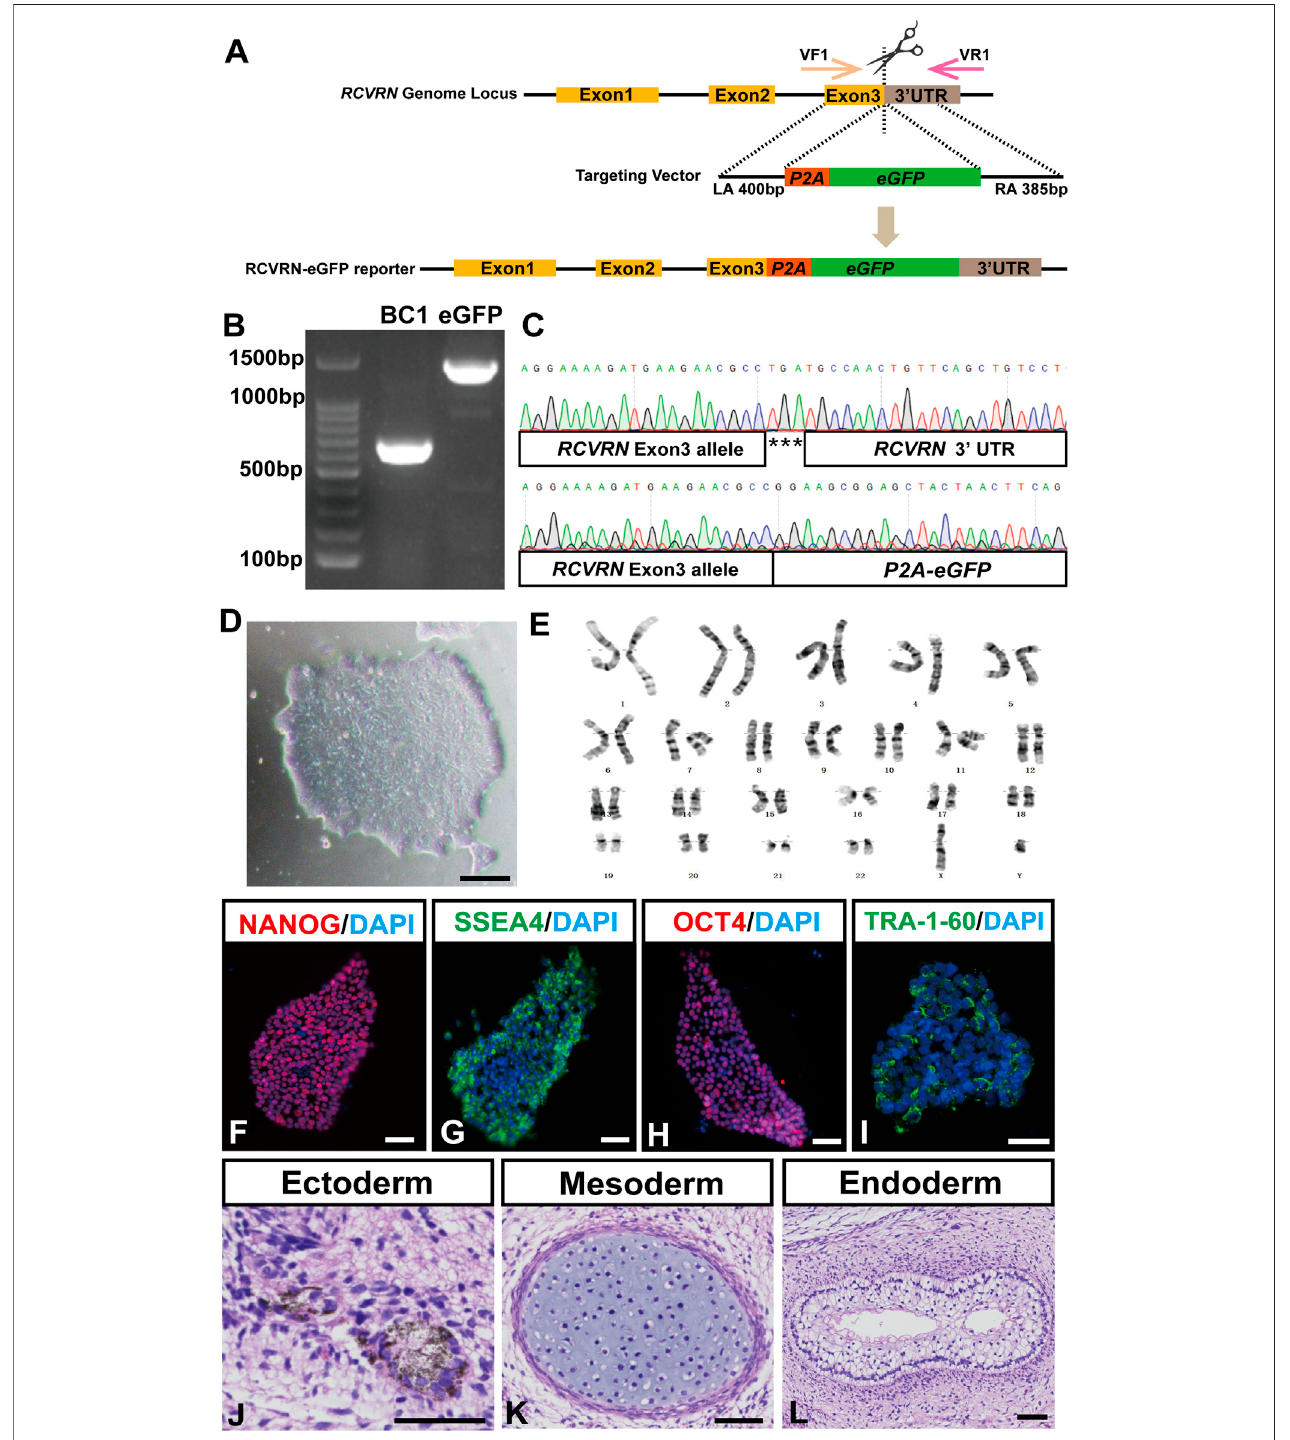
FIGURE 1 | Generation and characterization of the RCVRN-eGFP reporter hiPSCs. (A) Scheme of CRISPR/Cas9 mediated genome editing used to generate the RCVRN-eGFP reporter. VF1, validation forward primer 1; VR1, validation reverse primer 1; UTR, untranslated region; LA, left arm; P2A , porcine teschovirus 2A self- cleavingpeptide; eGFP ,enhanced green fl uorescenceprotein; RA,rightarm. (B) Veri fi cationoftheeGFPcassette insertionbyPCRampli fi cation ofgenomic DNA.BC1, parental hiPSCs; eGFP, hiPSCs with eGFP cassette insertion. (C) Sanger sequencing of the reporter hiPSCs showed the correct insertion of the P2A-eGFP at the endogenous RCVRN locus. (D) A typical clone of the reporter hiPSCs. (E) G-banding analysis of the reporter hiPSCs. (F – I) Immuno fl uorescence images showed the expressionofthepluripotencymarkersNANOG,SSEA4,OCT4,andTRA-1-60inthereporterhiPSCs.NucleiwerestainedwithDAPI. (J – L) Histologicalstainingshowed three germ layers in teratomas derived from the reporter hiPSCs: ectoderm (pigment cells), mesoderm (cartilage tissue), and endoderm (glandular tissue). Scale bars, 50 μ m (D, F-L).